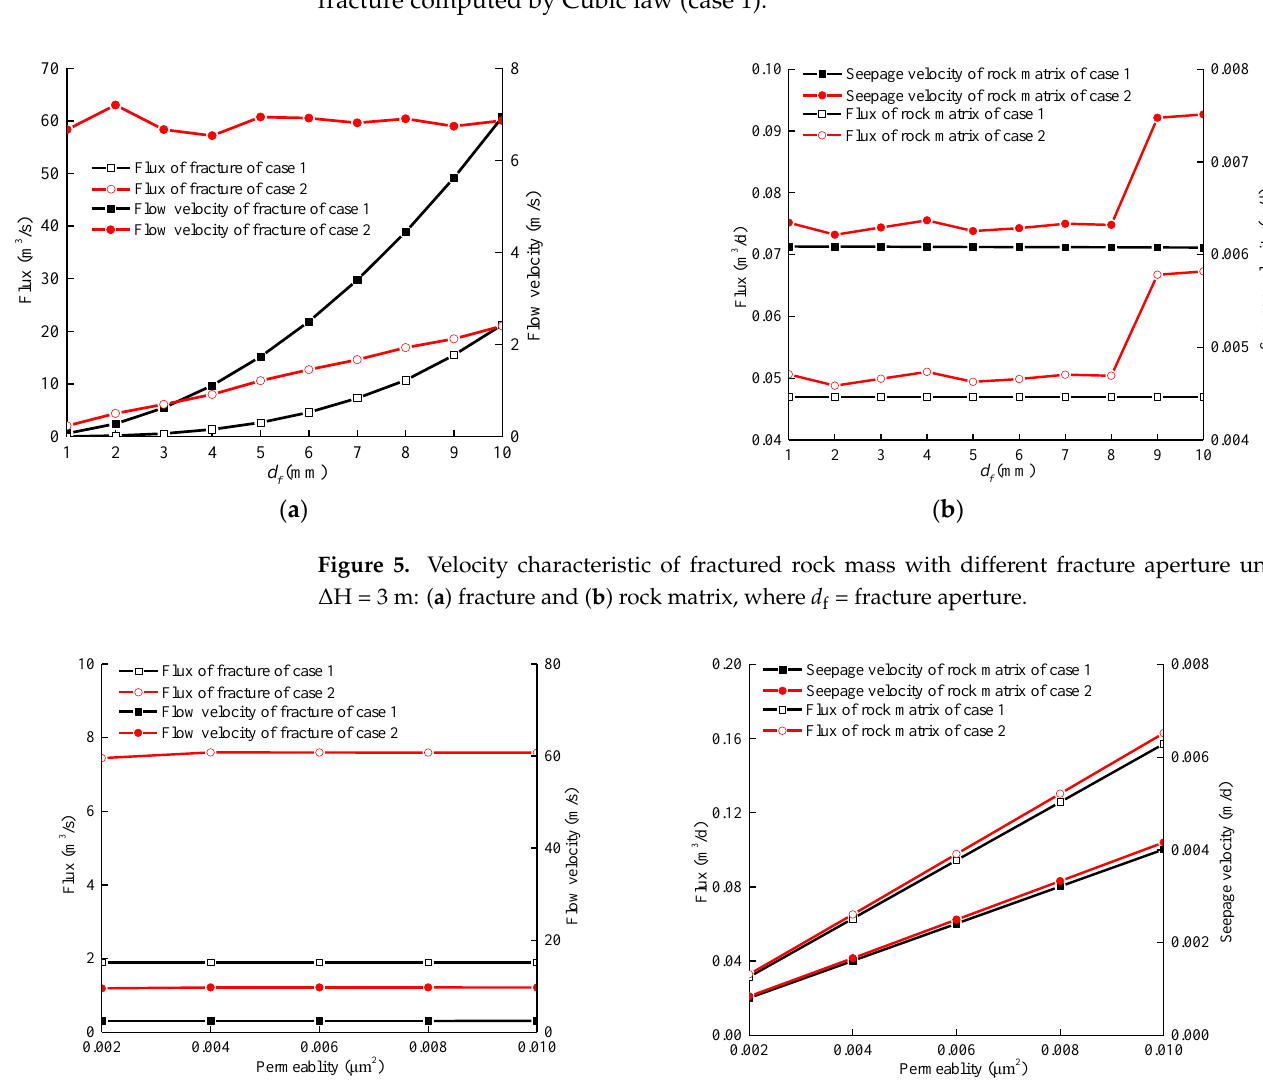
Figure 5. Velocity characteristic of fractured rock mass with different fracture aperture under  H = 3 m: ( a ) fracture and ( b ) rock matrix, where d f = fracture aperture.